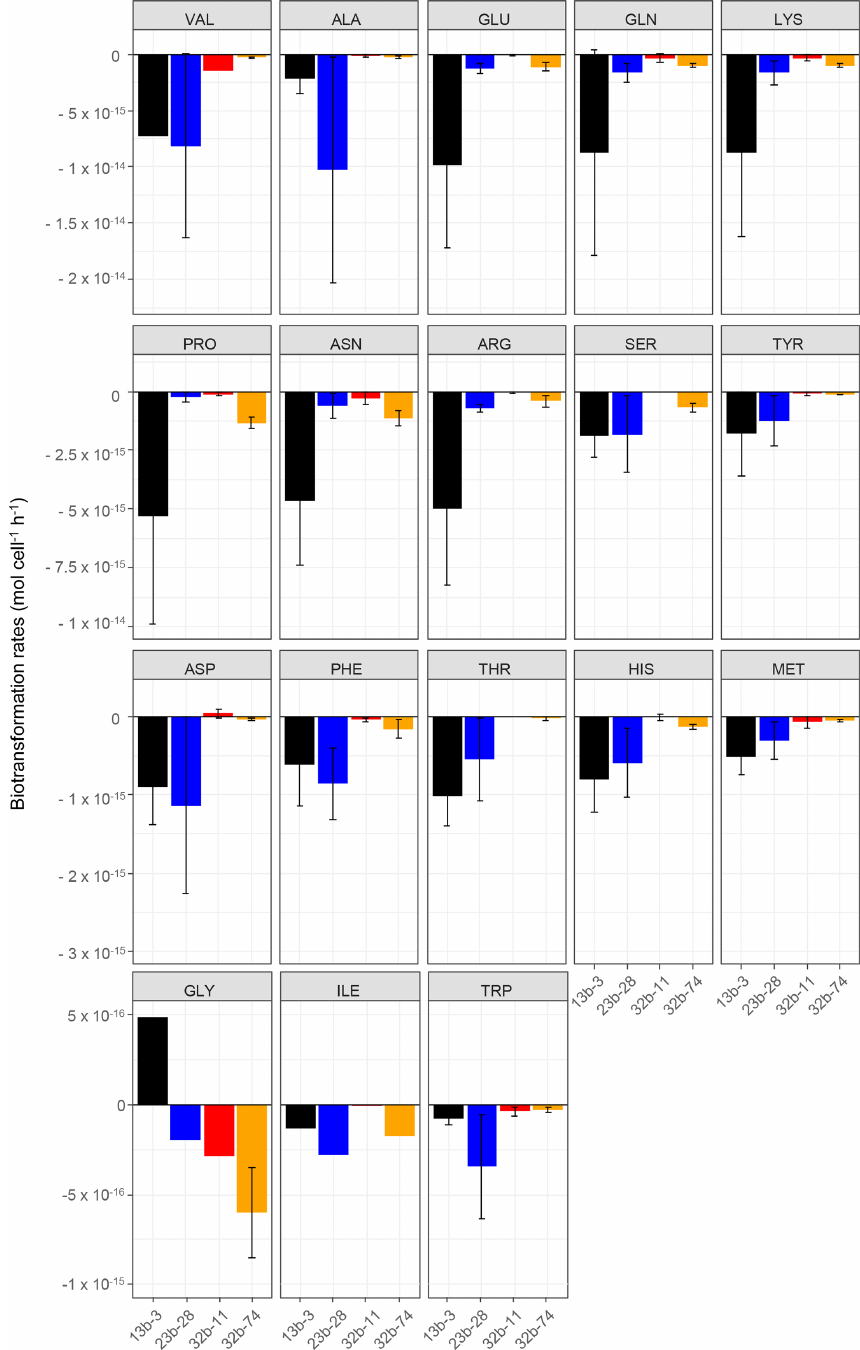
Figure 1. Biotransformation rates obtained for each amino acid and each bacterial strain: Pseudomonas graminis PDD-13b-3 (black), Rhodococcus enclensis PDD-23b-28 (blue), Sphingomonas sp. PDD-32b-11 (red), and Pseudomonas syringae PDD-32b-74 (orange). The experiments were performed in microcosms containing the mixture of the 19 AAs in an artificial-cloud medium. The standard error bars reflect the significant biological variability measured from three triplicates (independent